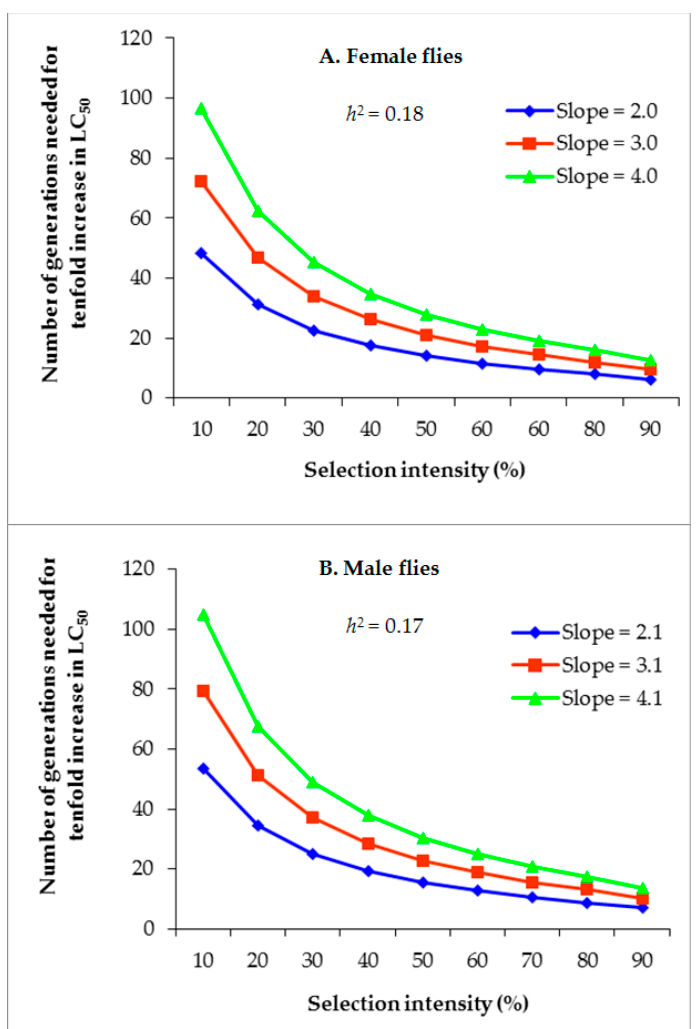
Figure 3. Effect of different slope values on the number of M. domestica generations required to increase the LC 50 of alpha-cypermethrin by tenfold at different selection intensities, A = female flies and B = male flies.